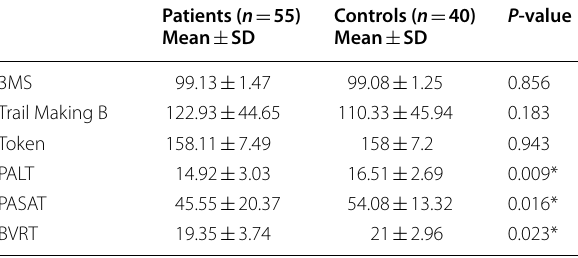
Table 1 Cognitive assessment in patients and control